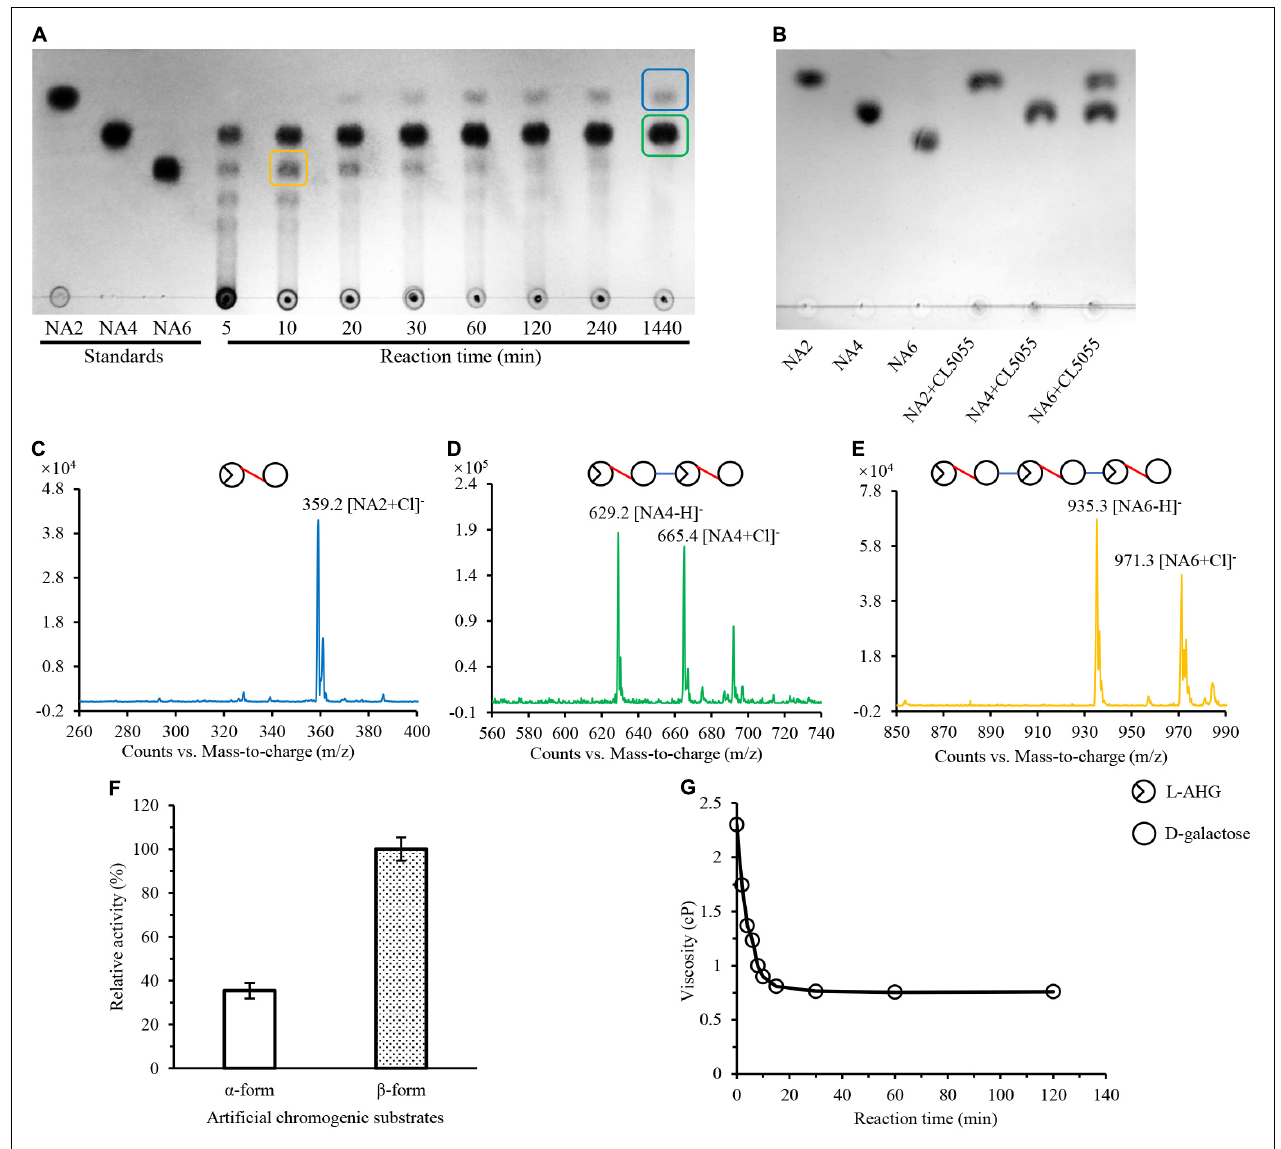
FIGURE 4 | Analysis of reaction products and mode of action of CL5055. (A) TLC analysis of the hydrolysis products of CL5055 incubated with agarose at the indicated intervals. (B) CL5055 hydrolyzed neoagarohexaose into neoagarobiose and neoagarotetraose as two end products. (C) Mass spectrum of one spot corresponding to neoagarobiose. (D) Mass spectrum of one spot corresponding to neoagarotetraose. (E) Mass spectrum of one spot corresponding to neoagarohexaose. (F) Substrate specificity of CL5055 toward two artificial chromogenic substrates, p-nitrophenyl- α -D-galactopyranoside and p-nitrophenyl- β -D-galactopyranoside. (G) Viscosity changes of the CL5055 reaction mixture. AHG, 3,6-anhydro-L-galactose; NA2, neoagarobiose; NA4, neoagarotetraose; NA6, neoagarohexaose.